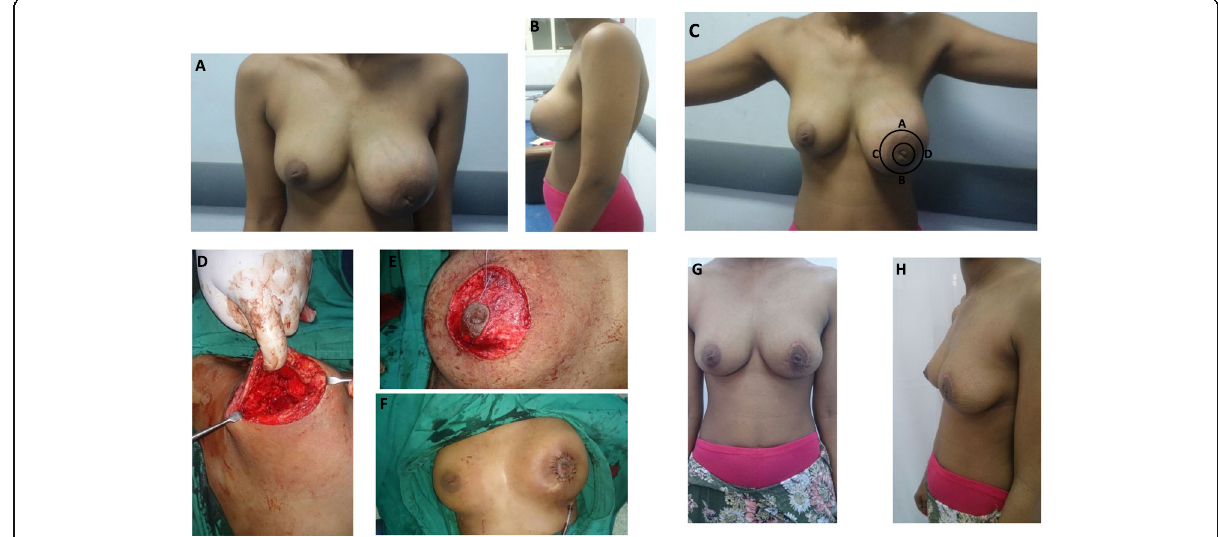
Fig. 1 a The preoperative appearance of both breasts. The left breast was hugely enlarged by the giant mass. b The preoperative lateral view of appearance of the left breast. c Preoperative markings for periareolar mastopexy. (a) Future superior point of the nipple (nipple to-sternal notch). (b) Future inferior point of the nipple (nipple-to-infra-mammary fold distance). (c) Medial limit of the nipple. (d) Lateral limit of the nipple. All these point was measured in comparison with normal contralateral breast dimensions. d After tumor excision through lower half of preplanned outer circular periareolar incision. e Round block suture technique to recruit peripheral skin around new areola. f Immediate post-operative view. g, h Three months postoperative anterior and lateral view of the patient. The breast symmetry and projection have been